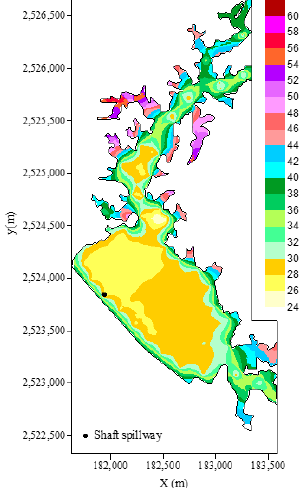
Figure 3. Bed elevation in storage area of A-Gong-Dian reservoir.